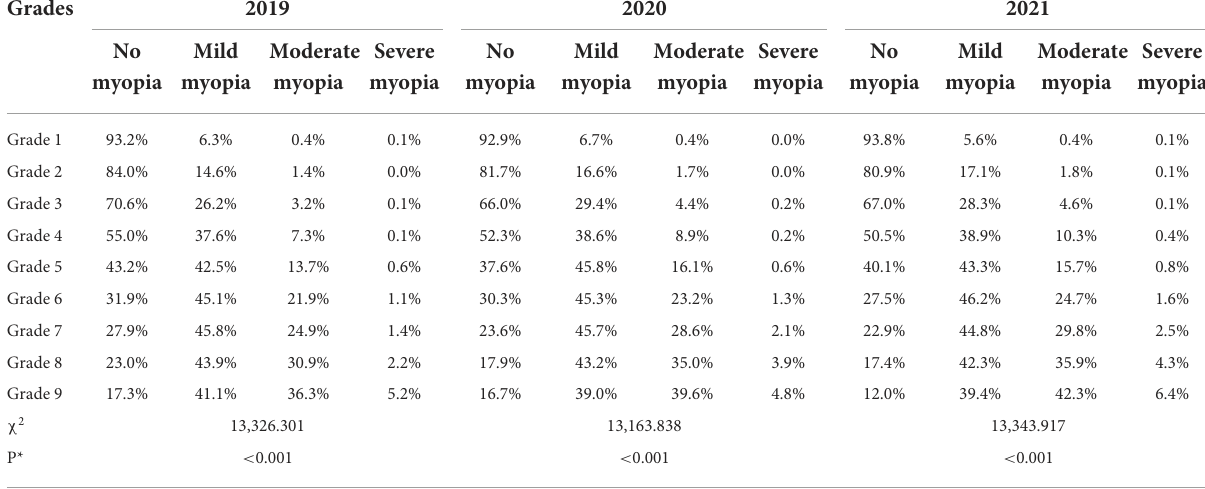
TABLE 5 The percentage of different degrees of myopia from grades 1 to grade 9 over the 3 years.